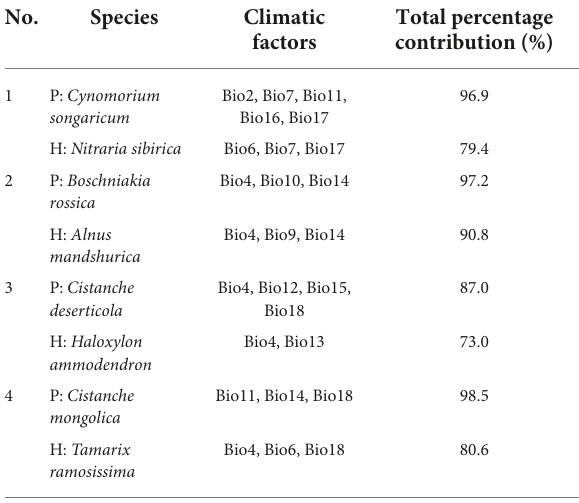
TABLE 2 Key climatic factors influencing habitat distribution of four holoparasitic plants and their primary hosts in China. No.